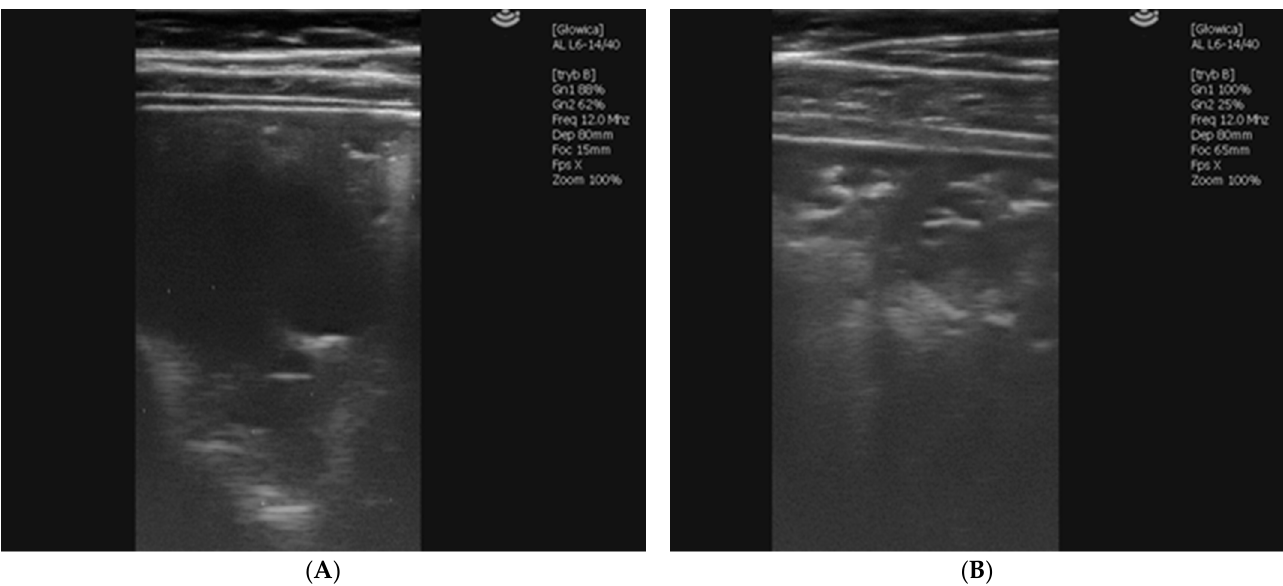
Figure 4. Ultrasonographic picture of an irregular abscessation with hypoechoic fluid in the left lobe in 11th ICS ( A ) and a multifocal abscessation in the right lobe from 11th ICS cranially in the right lobe ( B ) observed during the first examination of Case 2.2. ( B ) observed during the first examination of Case